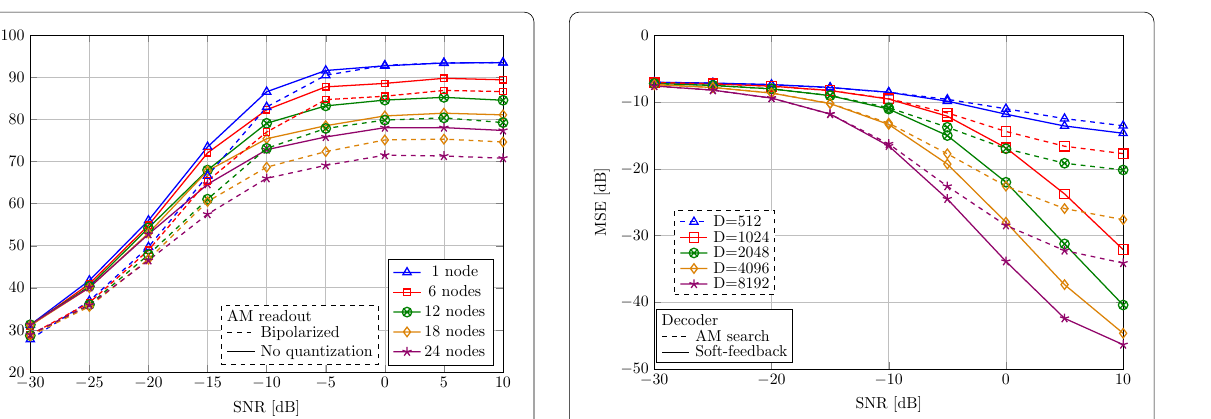
Fig. 13 Classification accuracy (%) in 5-class gesture recognition on 64-channel EMG at D = 2048 . The transmitted HD vector is interfered with other nodes